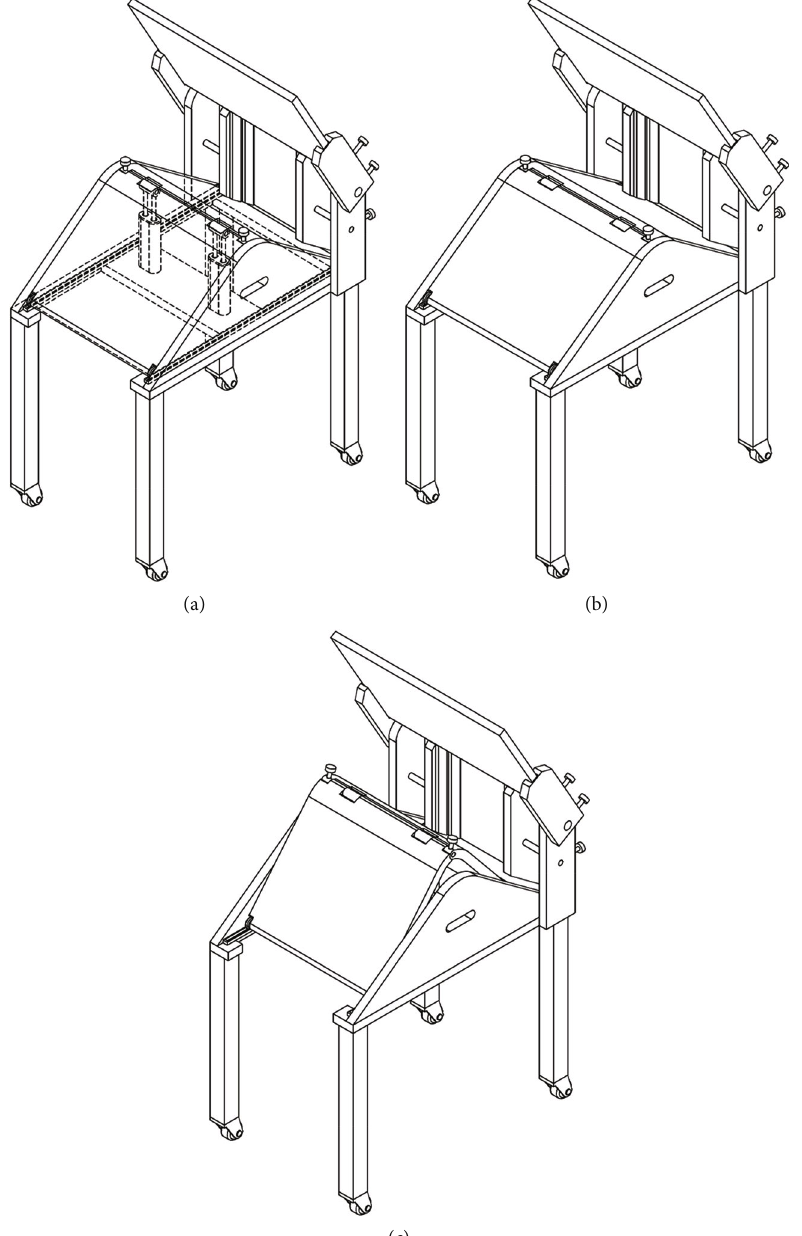
Figure 1: Development of patellofemoral joint radiography auxiliary device (PJR). (a) Structure of the PJR. (b) The form of widening the angle of the PJR. (c) The form of narrowing the angle of the